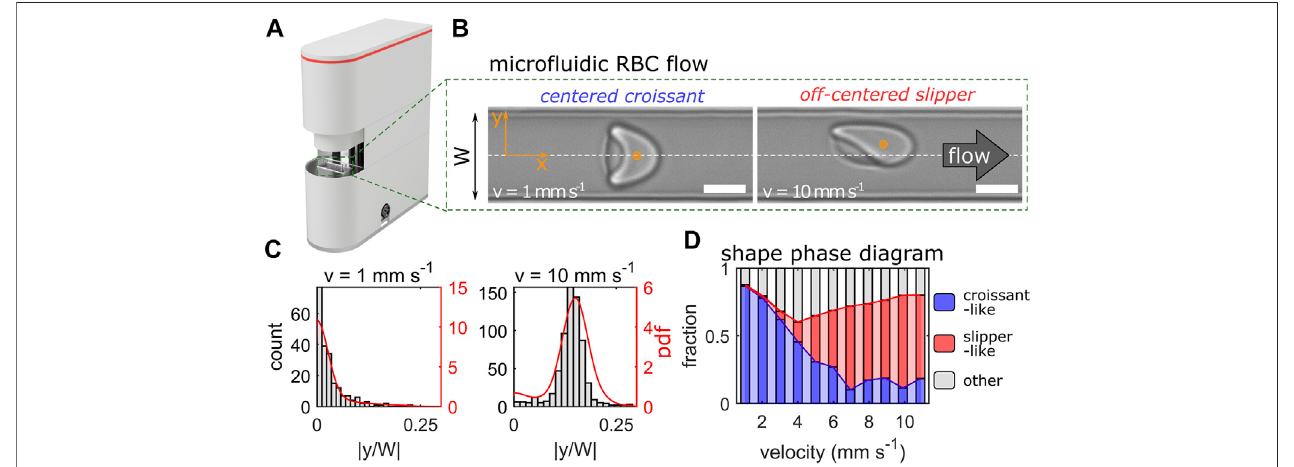
FIGURE 1 | Erysense ® device and principle of measurement. (A) Image of the Erysense ® device. (B) Representative images of a croissant-shaped and a slipper- shaped RBC at low (1 mm/s) and high (10 mm/s) velocity, respectively. Scale bars represent 5 µm. Flow is from left to right and the dashed white line indicates the channelcenterlineinthe y -directionwithachannelwidthW. (C) Representativehistogramsandprobabilitydensityfunctions(pdf)ofthenormalizedcell ’ scenter-of-mass in y -direction at a low (1 mm/s) and high (10 mm/s) velocity. (D) Representative shape phase diagram of a healthy control showing croissant-like, slipper-like, and other RBC shapes as a function of the cell